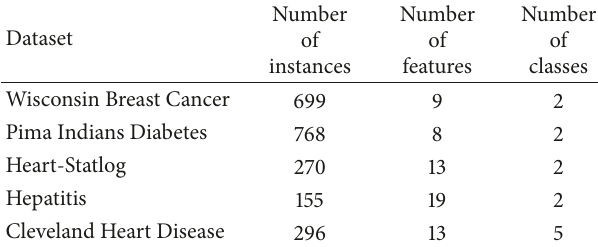
Table 1: Description of